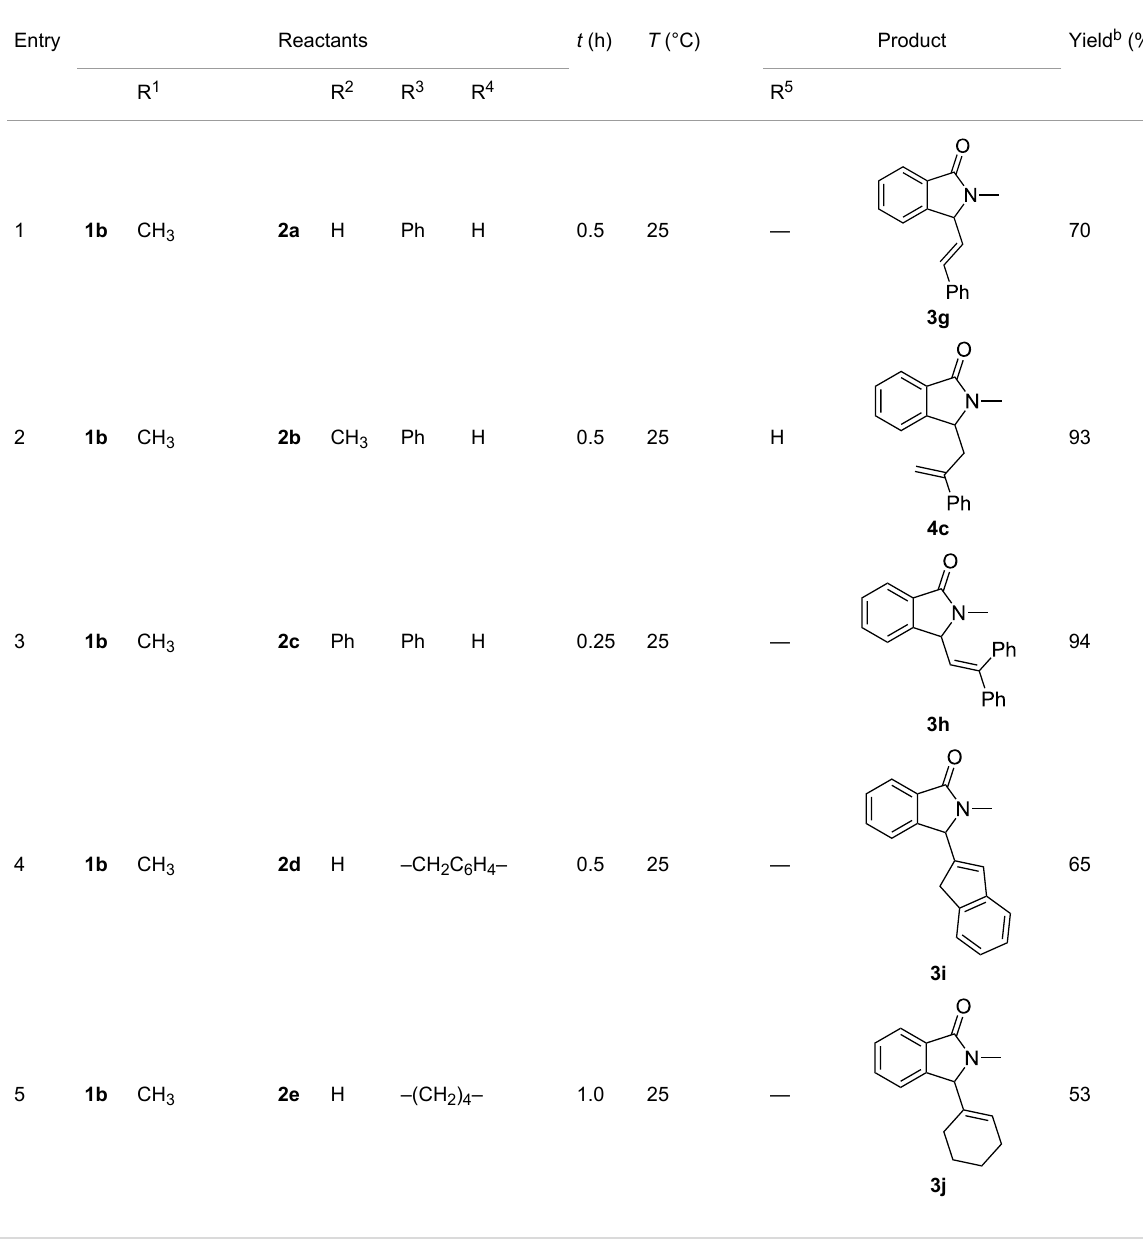
Table 3: The reactions of 3-hydroxyisoindol-1-one ( 1b , c ) with olefins 2 in the presence of BF 3 ·OEt 2 . a